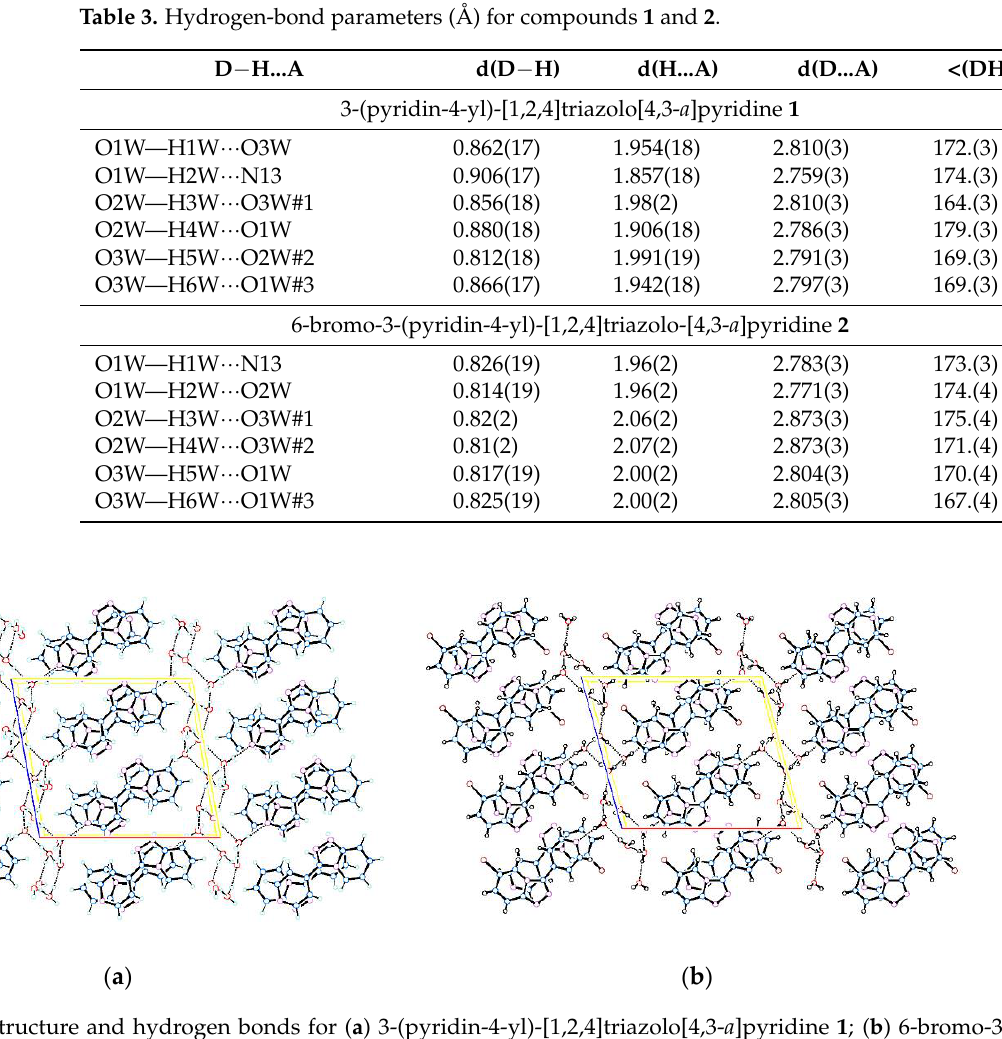
Figure S4: 13 C NMR of 2 , Figure S5: FTIR-Spectrum of 1 , Figure S6: FTIR-Spectrum of 2 , Figure S7: Fragment Ion Scan of 1 , Figure S8: Fragment Ion Scan of 2 , Figure S9: Fragment Ion Scan of 2 , Table S1: Crystal data and structure refinement for 1 , Table S2: Atomic coordinates and equivalent isotropic displacement parameters (Å 2 ) for 1. U(eq) is defined as one-third of the trace of the orthogonalized U ij tensor, Table S3: Anisotropic displacement parameters (Å 2 ) for 1. The anisotropic displacement factor exponent takes the form: -2 π 2[ h2 a*2U11 + . . . + 2 h k a* b* U12 ], Table S4: Hydrogen coordinates and isotropic displacement parameters (Å 2 ) for 1, Table S5: Bond lengths [Å] and angles [ ◦ ] for 1, Table S6: Torsion angles [ ◦ ] for 1, Table S7: Hydrogen bonds for 1 [Å and ◦ ], Table S8: Crystal